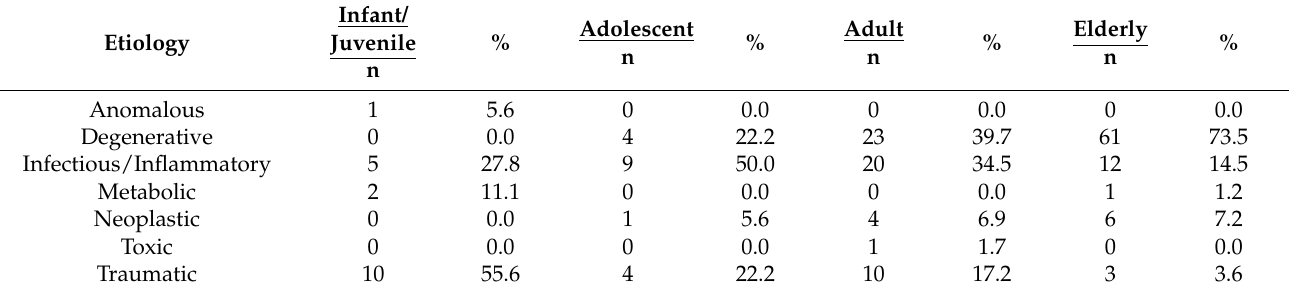
Table 3. Age-specific